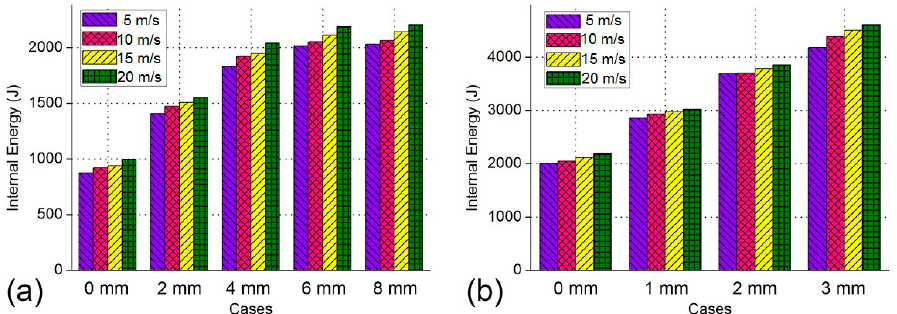
Figure 15. The absorbed energy of bionic honeycomb structures with different impact velocity: ( a ) BHS-1; ( b ) BHS-2.